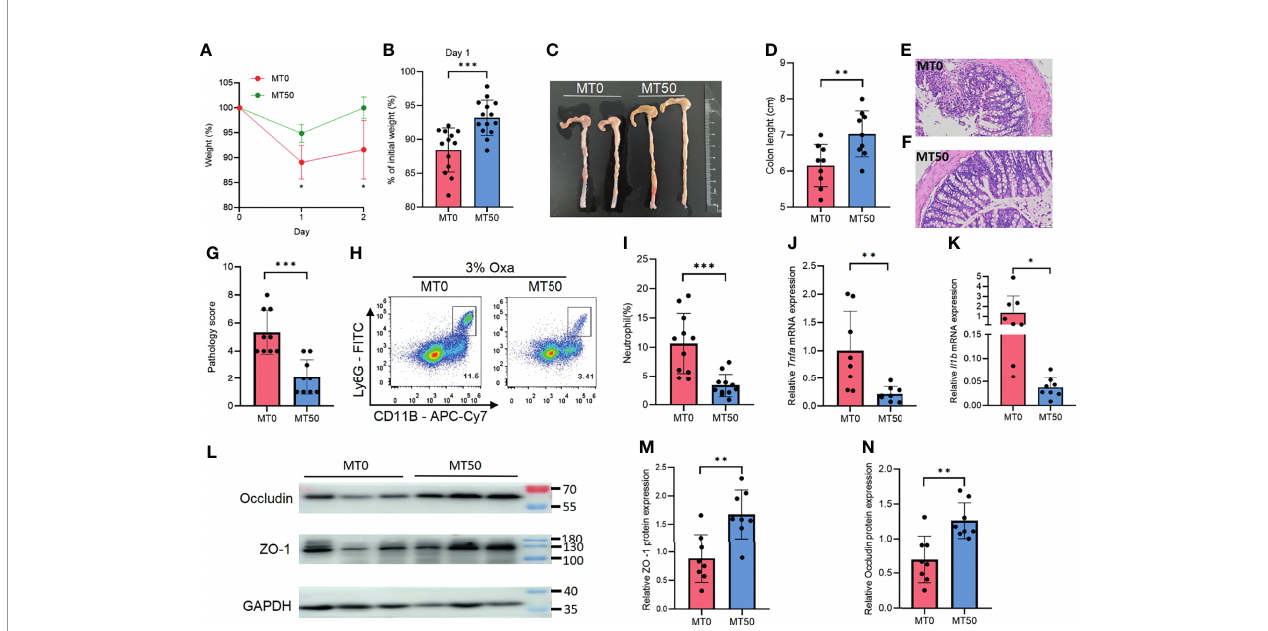
FIGURE 2 | Melatonin mitigates oxazolone (Oxa)-induced colitis. (A) Body weight changes after 3% Oxa-treated (day 0). (B) Weight changes at day 1. (C, D) Colon length at day 1. (E – G) Representative H&E staining (×20) and pathological score of the in fl amed gut epithelium. (H, I) Flow cytometry analysis of colonic CD45 + CD11b + Ly6G + neutrophil subsets in melatonin-treated and melatonin-untreated mice at day 1 after 3% oxazolone enema. (J, K) qPCR of Tnfa and Il-1b mRNA in colonic tissues in melatonin-treated and melatonin-untreated mice at day 1 after 3% oxazolone enema (all values were normalized to the melatonin-untreated group). (L) Immunoblot for ZO-1 and occludin in colonic tissue and (M, N) the densitometric analysis of ZO-1 and occludin immunoblot of melatonin-treated and melatonin-untreated mice. Data are representative of at least two independent experiments. Data are shown as mean ± SD. * p < 0.05; ** p < 0.01; *** p <